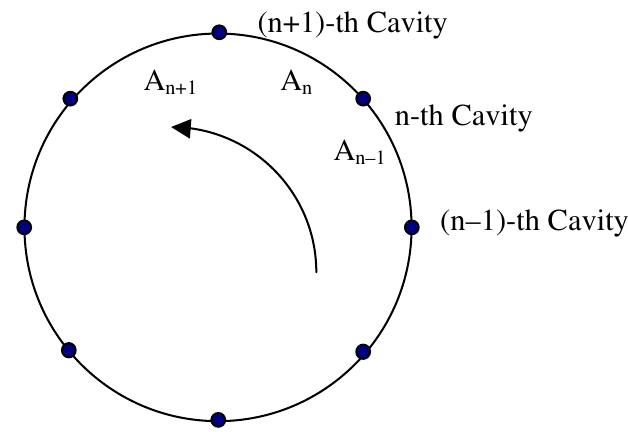
FIG. 1. (Color) FFAG ring with multiple equally spaced rf